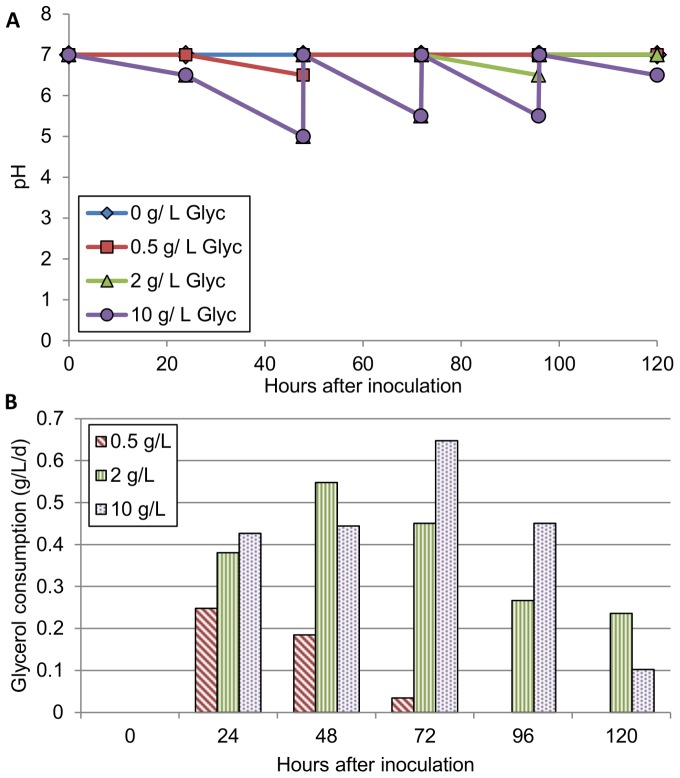
pH change and glycerol consumption in axenic C. minutissima cultures.A: The line graph shows a decline in pH. Similar pH declines were observed in glucose cultures. pH was re-adjusted to neutral conditions every 24 hours. B: The bar graph shows the rate of glycerol consumption by the cultures during each 24-hour period.